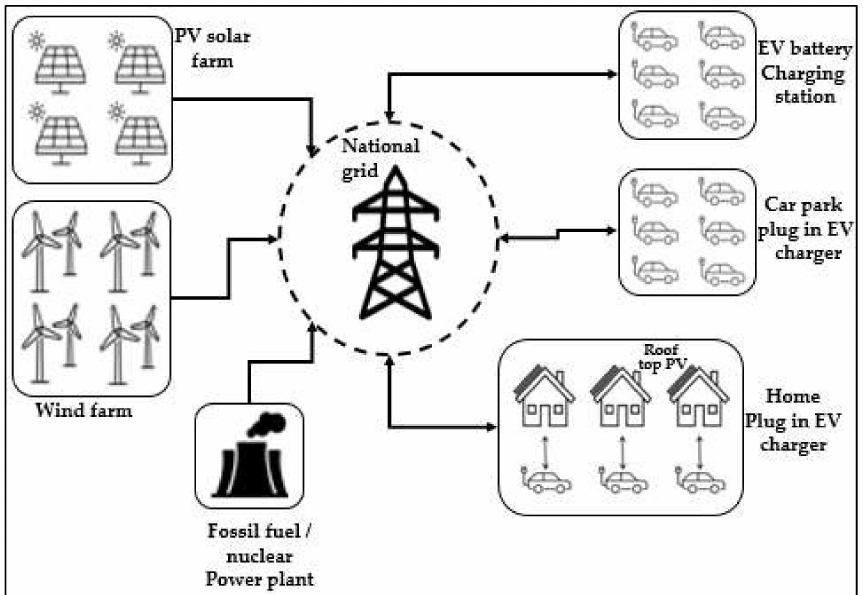
Figure 12. Schematic layout of V2G